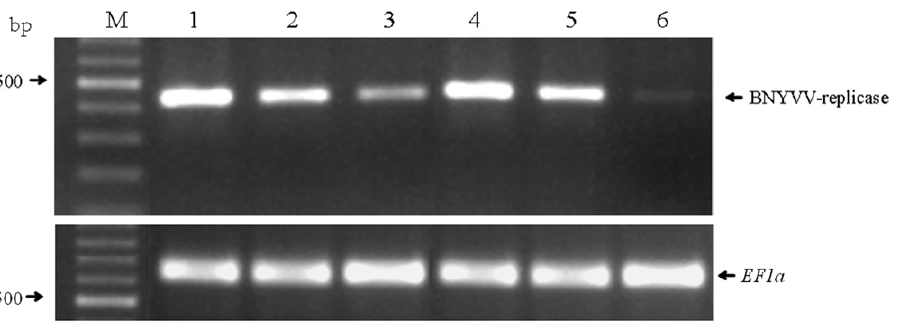
Figure 2. RT-PCR amplification products obtained from transgenic N.benthamiana plants expressing the BNYVV replicase-derived transgene. Lane M: Marker in bp (Gene Ruler Ladder mix, Fermentas). Lanes 1, 2, 3: Representative T2 double transgenic plants, expressing the hrpZ Psph and the BNYVV replicase-derived transgenes, presenting high, moderate and low resistance levels, respectively. Lanes 4, 5, 6: Representative T2 GW-IR3-transformed plants presenting high, moderate and low resistance levels, respectively. The EF1a gene transcript is used as loading control for equal amounts of RNA.